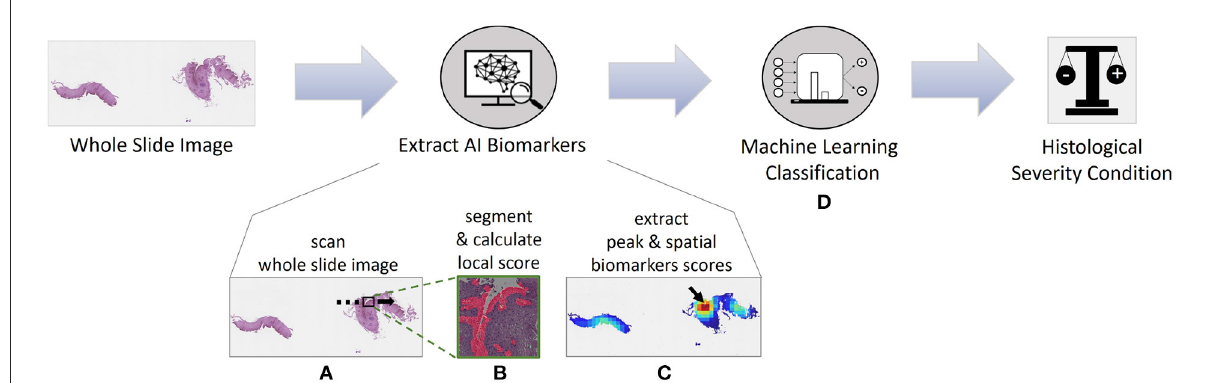
FIGURE1 Artificial intelligence pipeline for diagnosing whole slide images (WSIs) and predicting disease activity of patients with eosinophilic esophagitis (EoE). (A) First, we analyze the WSI with a high-power-field (HPF)-sized kernel. (B) For each HPF, we segment intact eosinophils (Eos-intact) and basal zone (BZ) areas to obtain a local score for both features. (C) Once we have the analyzed entire WSI, we extract four biomarker scores that depend on the spatial distributions of eosinophils and basal zone. (D) We use these four biomarkers to predict the histological severity of the patients’